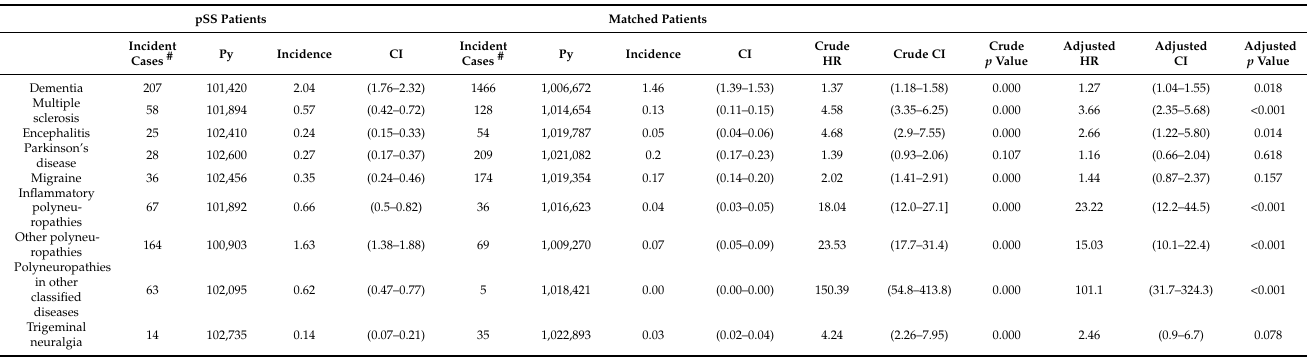
Table 2. Hospitalization risks for neurological diseases in primary Sjögren’s syndrome patients compared to hospitalized matched